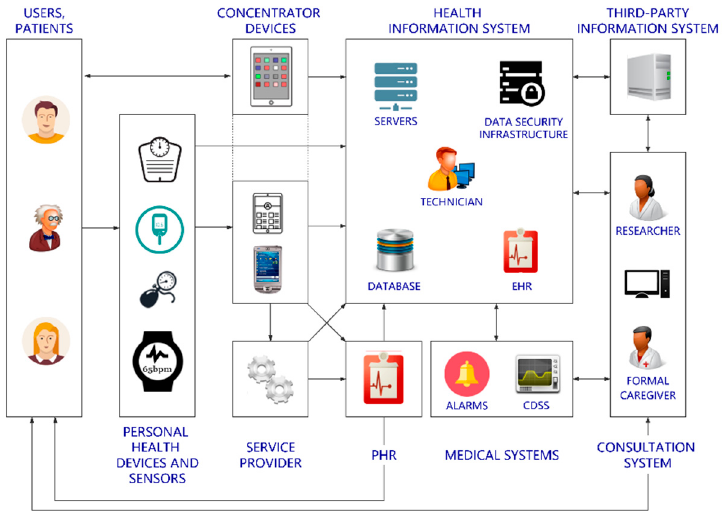
Figure 1. Actors and communication flows in a traditional mobile health architecture.